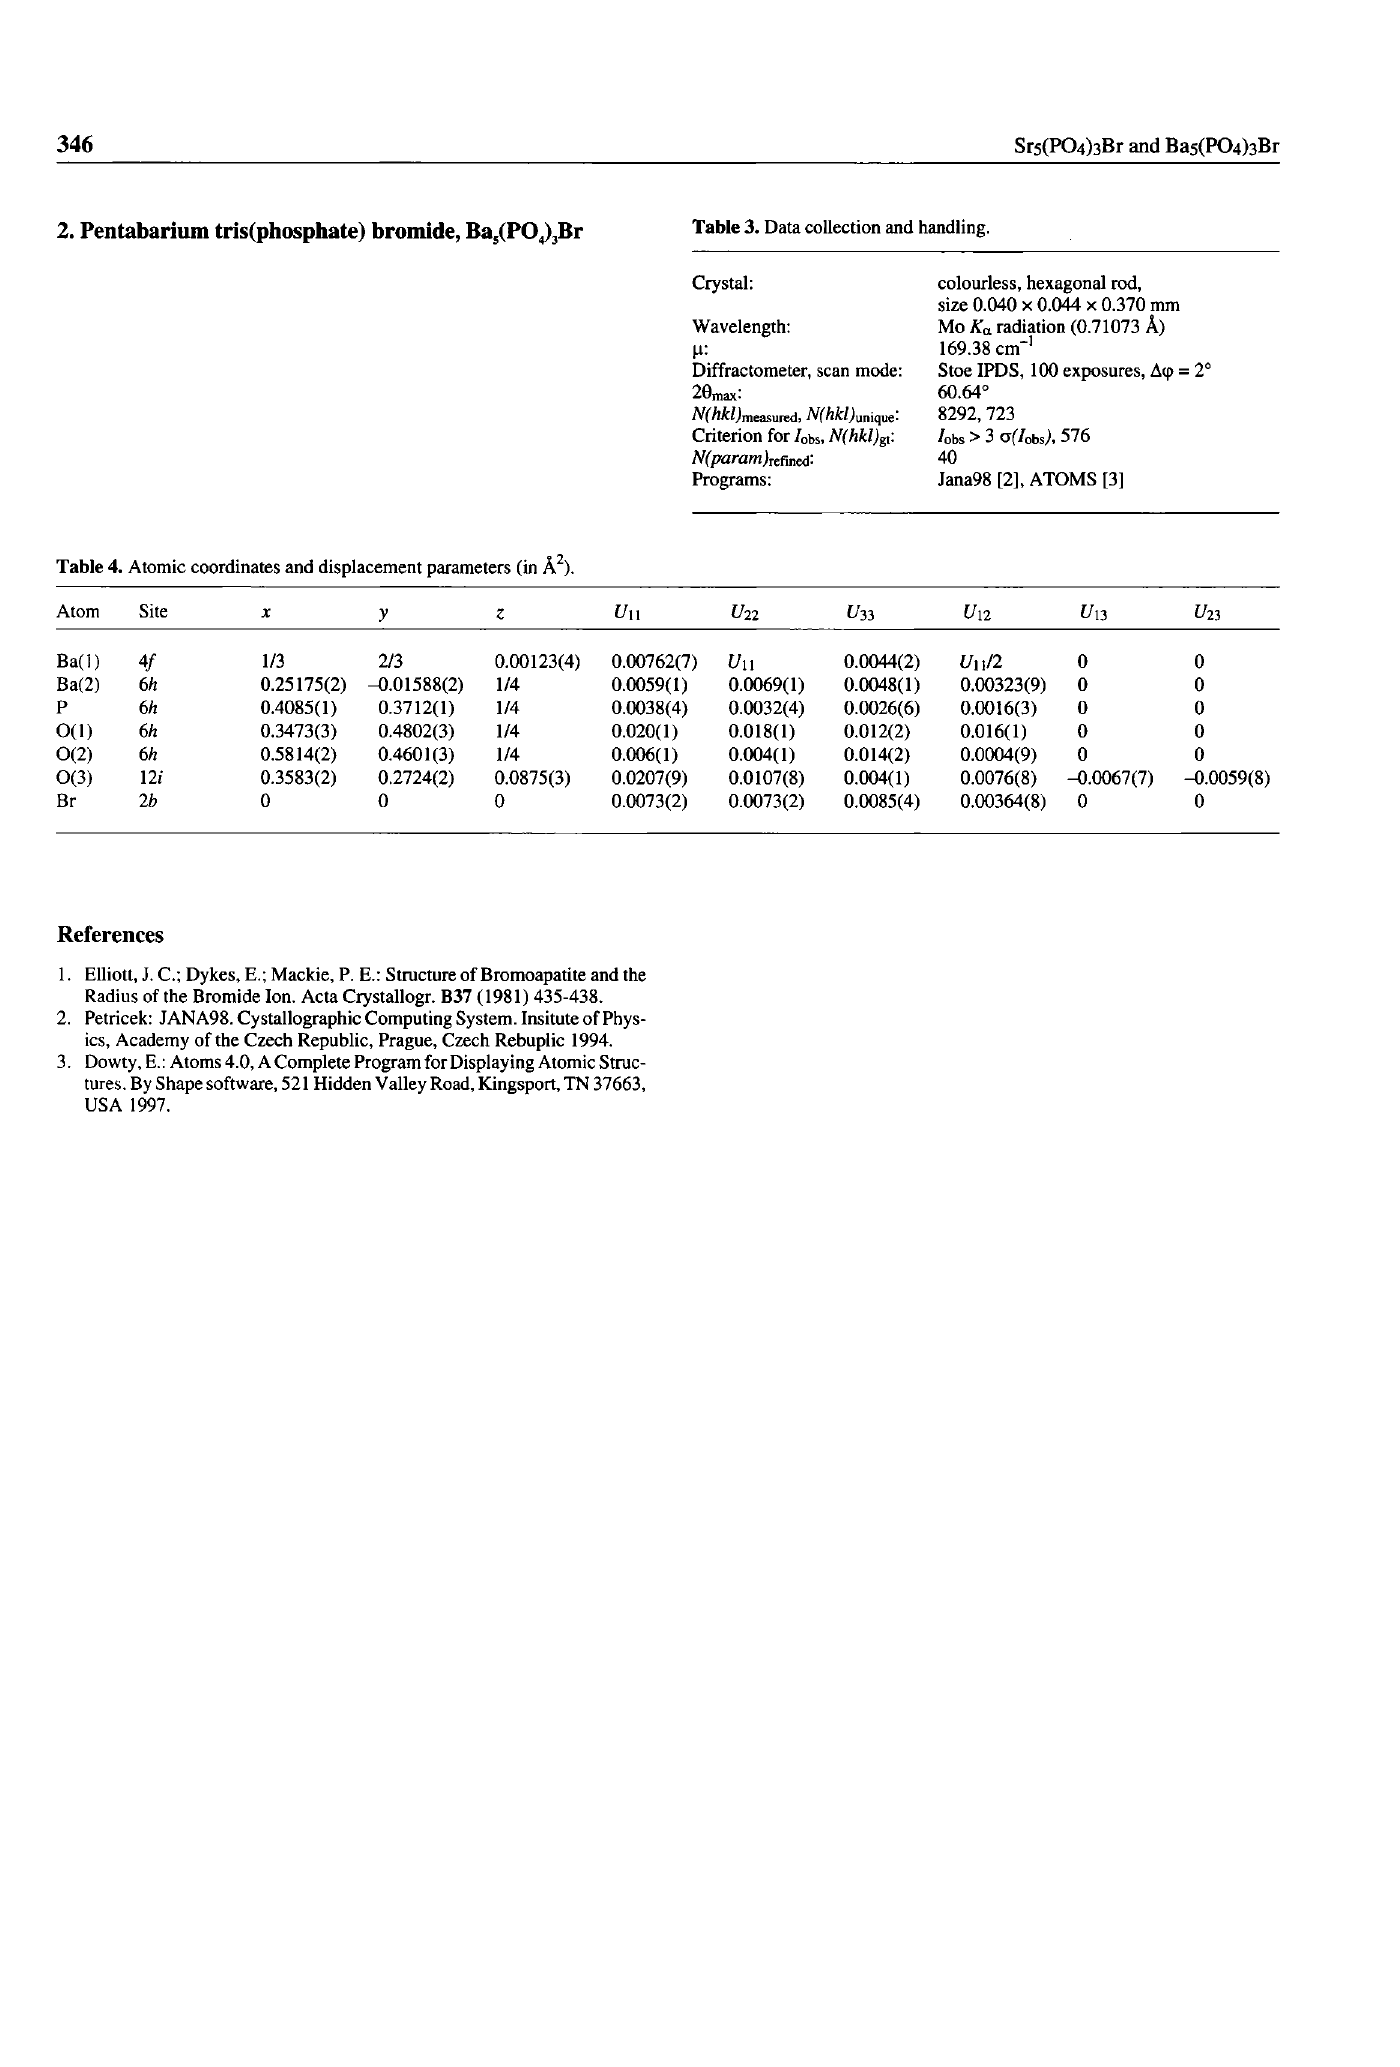
Table 3. Data collection and handling.